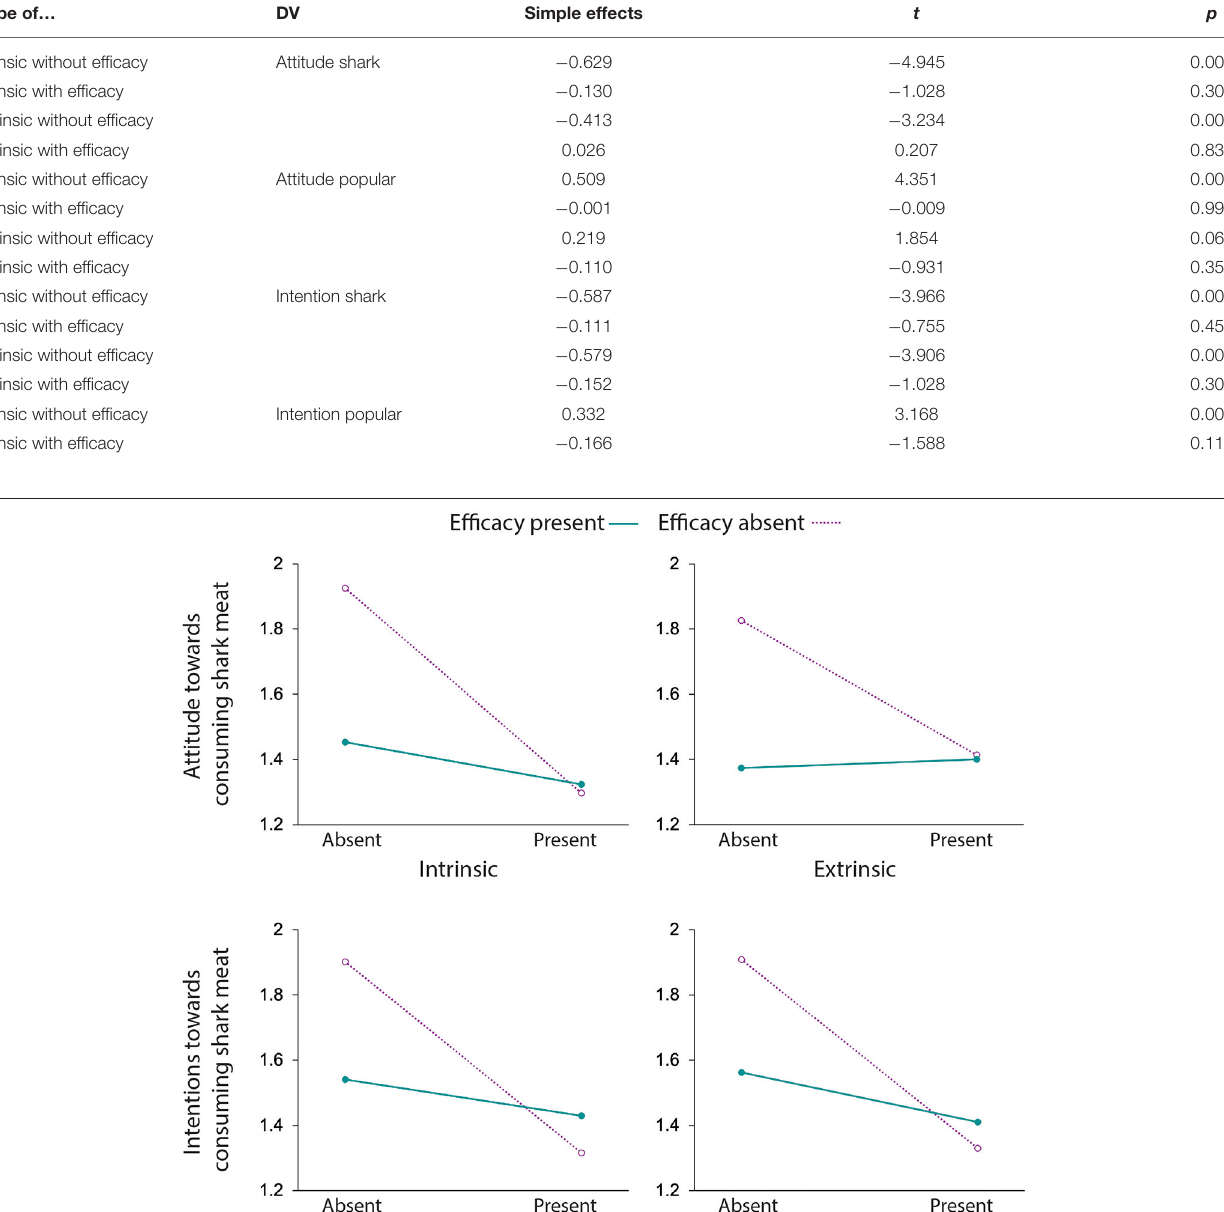
TABLE 4 | Simple slope analysis of the interaction between intrinsic and extrinsic messages, and the efficacy message. Slope of…